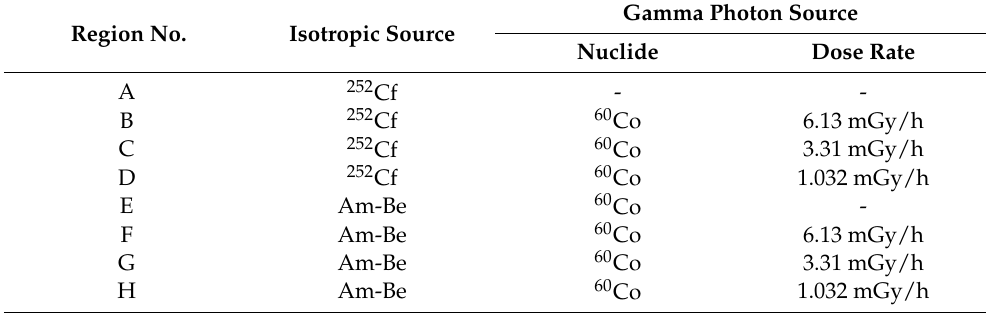
Figure 11. Histogram of detection data under different radiation conditions. (The time required to exchange radiation source and replacement dose rate has been excluded). Table 2. Radiation field information.